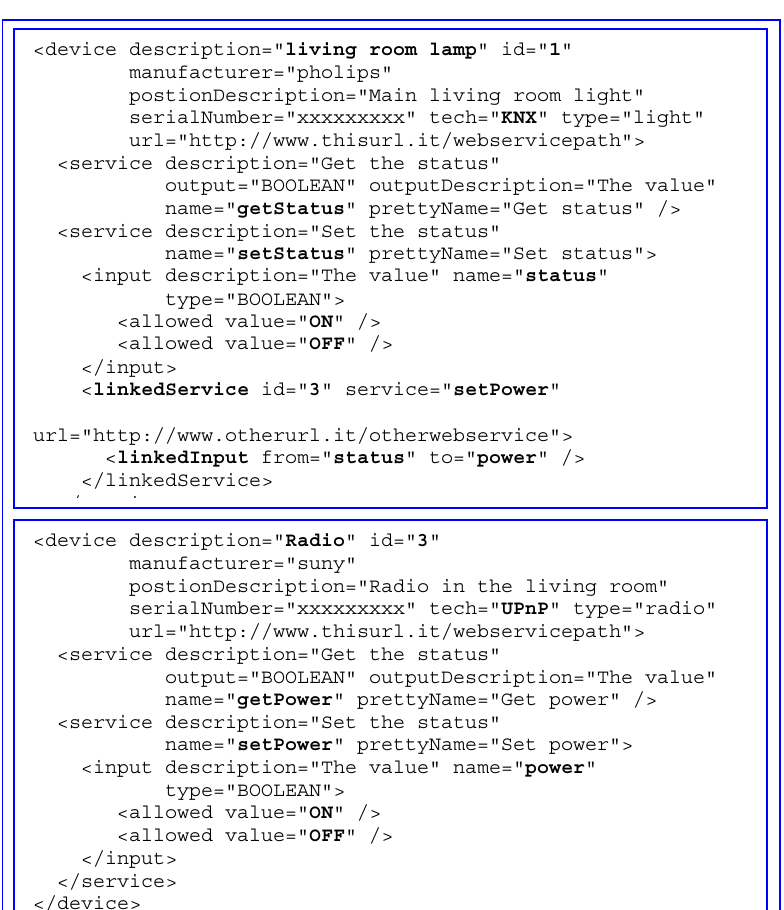
Figure 3. Examples of